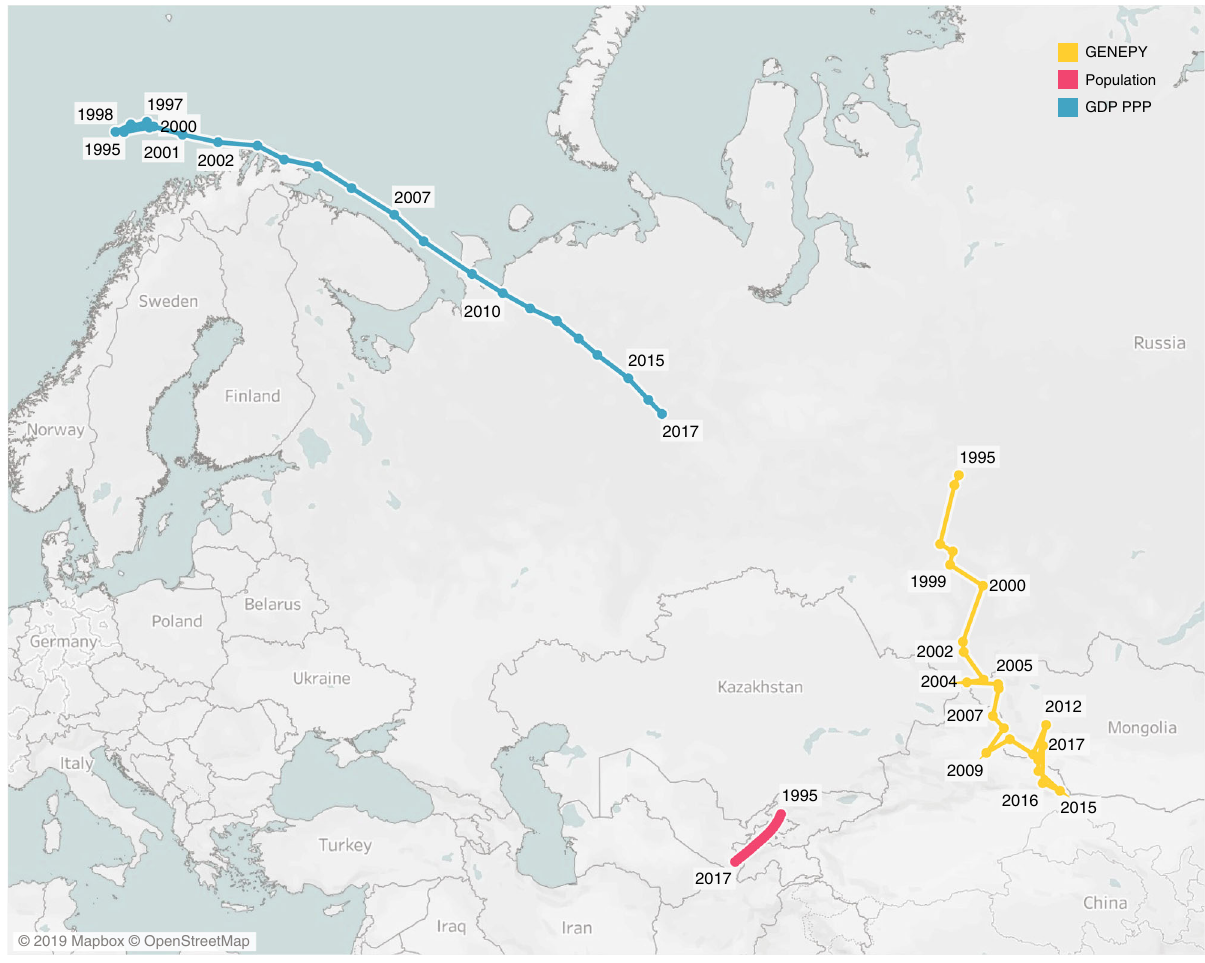
Fig. 3 The world ʼ s economic and demographic barycentre, 1995 – 2017. The trajectories are computed by weighting the countries ’ geographical centres by their GENEPY index, in yellow, the Gross Domestic Product at Purchasing Power Parity (GDP PPP), in blue, and the population size, in purple. The GDP trajectory is consistent with the one shown by the McKinsey Global Institute 47 taking as reference the path in there shown from 1990 – 2025. Data for the GDP PPP and the population of countries are provided by the World Bank. The coordinates of countries are provided by the Portland State University and de fi ned according to the georeference system WGS 1984. The fi gure has been produced with Tableau Public